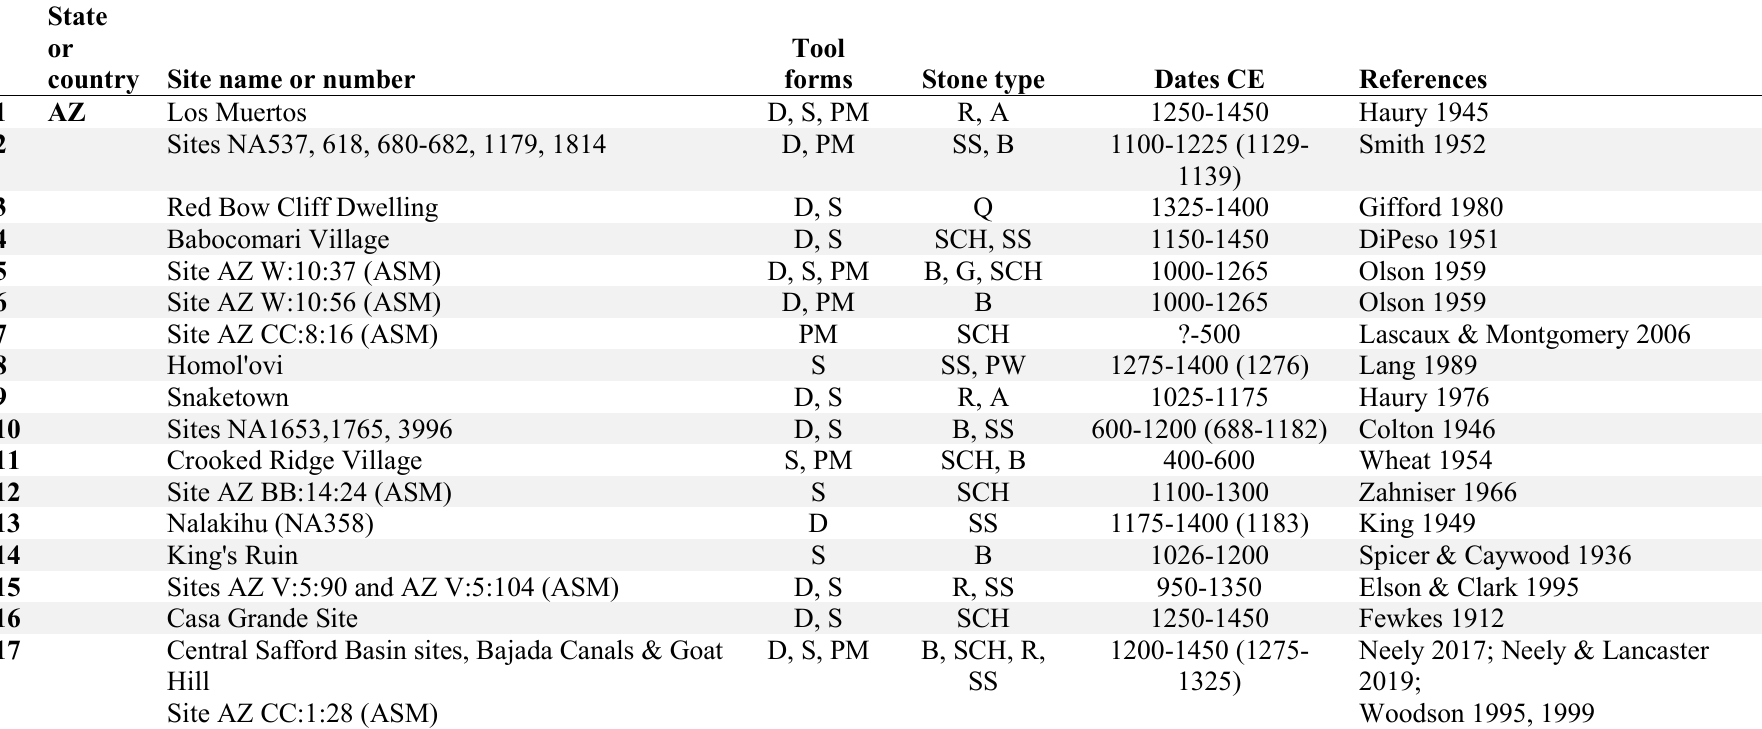
Table 5. The location, basic characteristics, and dating of examples of Prehistoric digging tool forms found in a brief literature search and from published and verified unpublished fieldwork finds. Numbers in the left column correspond with those next to the pentagons in the distribution map, Figure 15. The dates were derived from ceramic cross-dating and dendrochronology. Dates in parentheses indicate the most secure temporal placement of the sites by direct tree- ring associations (Kohler & Bocinsky 2015). State or Country: AZ: Arizona, NM: New Mexico, CO: Colorado, MX: Mexico. Tool Forms : D: